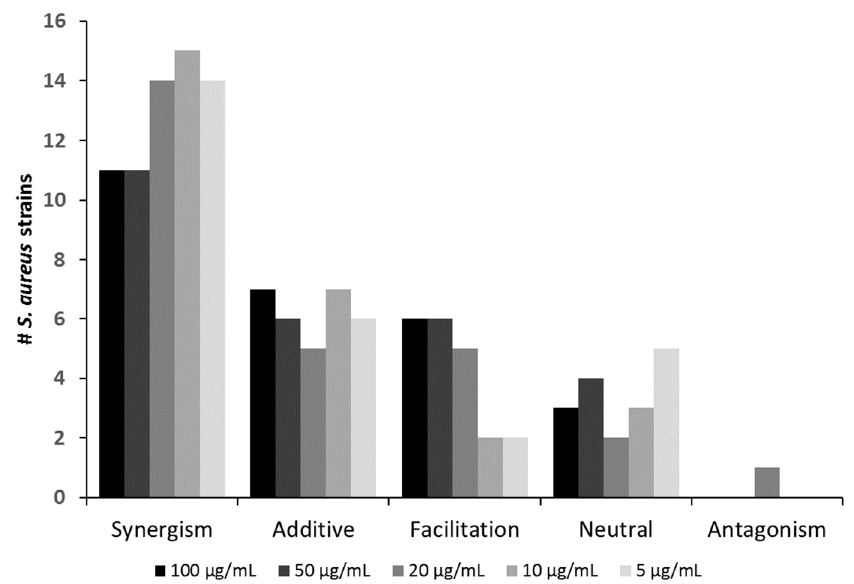
Figure 2. Number of S. aureus strains against which the phage Sb-1 (MOI 0.1) interacted in a positive, neutral, or antagonistic fashion with the antibiotic oxacillin at varying